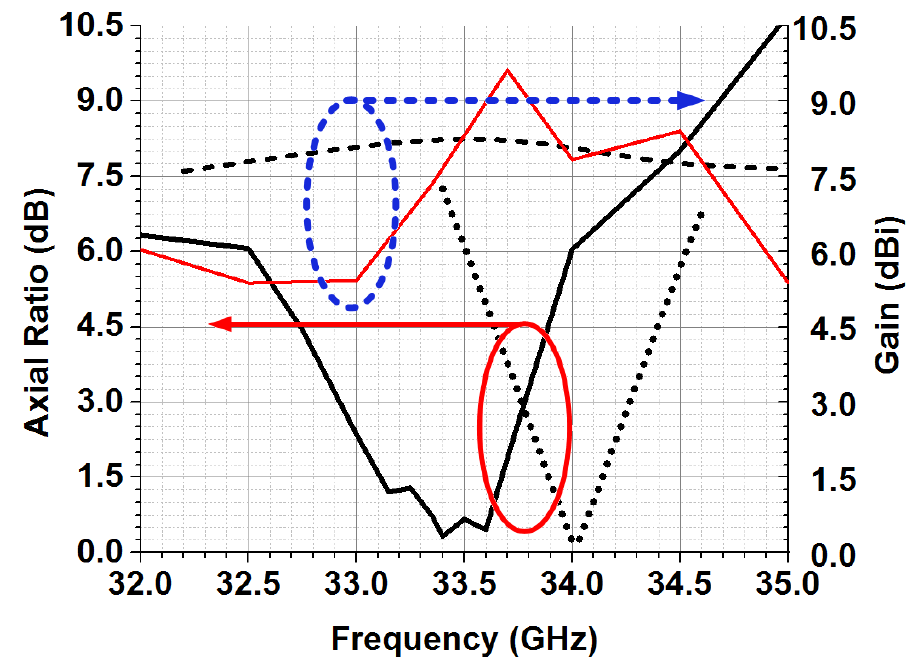
Figure 7. Designed antenna’s simulated and the measured far field performance graph including axial-ratio (AR) and peak-gain vs. frequency. Here the solid line represents the measured results and the dashed line stands for the simulated results.